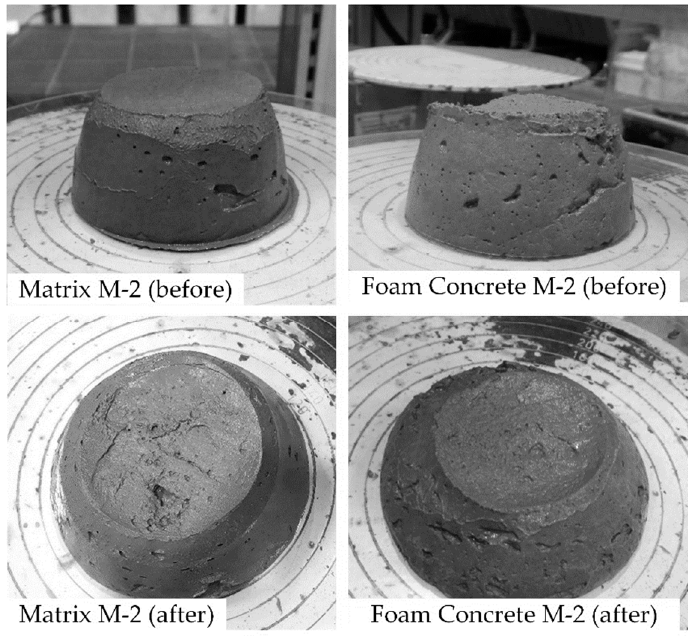
Figure 8. Flow spread of the cement-based matrix and the corresponding foam concrete composition M-2 before and after strokes.